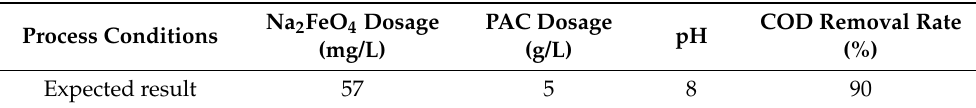
Table 4. Optimized experimental